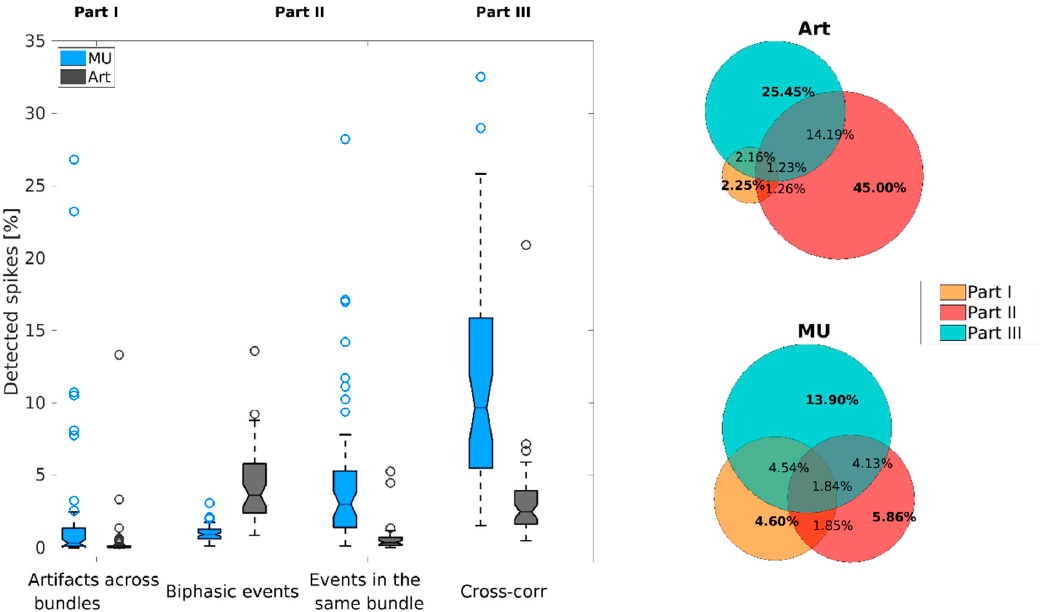
Figure A2. Detected spike events in automatically clustered data (i.e., automated classification of clusters as multi-unit (MU) and artifact only). On the left side, a boxplot of detected spike events (percentage of all extracted spikes from a given cluster class) separated by cluster types and by the parts of the DER algorithm is shown. Part II is subdivided into the detection within the same channel and the same bundle. The y -axis is limited to 35% for visualization. On the right side, the percentage of detected spike events per cluster type is shown, separated into the three parts of the algorithm. Bold numbers indicate the percentage of spikes found in each individual part. Non-bold numbers in the intersections show the percentage of spike events detected by several parts. For the purpose of visualization, intersecting areas are not to scale.